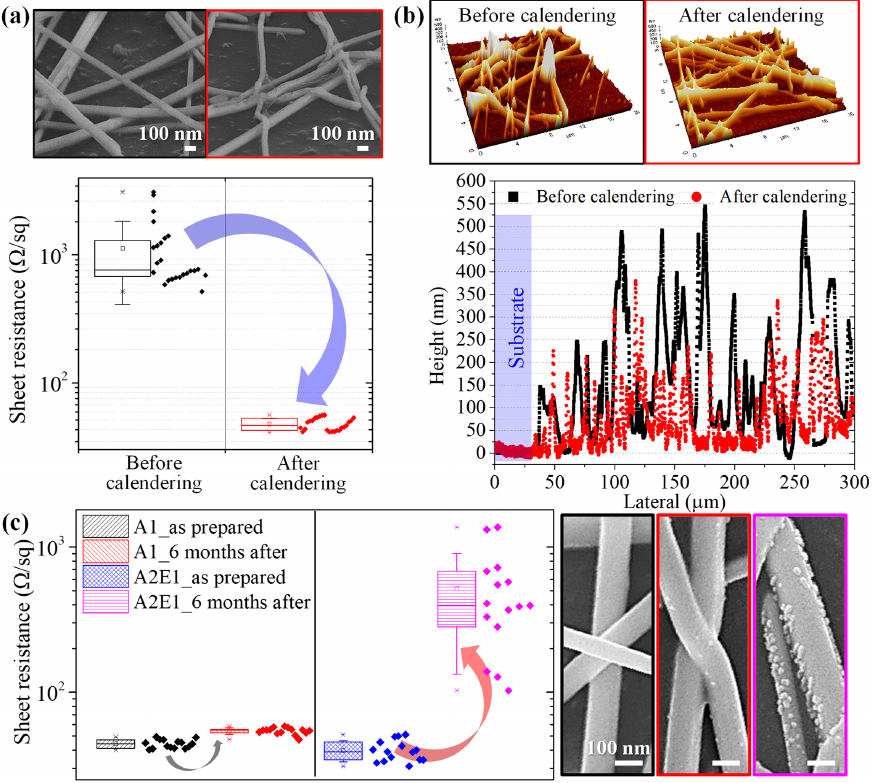
Figure 2. PVP-capped Ag NW TCFs calendered with flat roll: ( a ) FE-SEM images and sheet resistance change to demonstrate the effect of the calendering process, ( b ) AFM measurement of morphology. ( c ) FE-SEM images and sheet resistance change to show the effect of long-term oxidation when two different washing schemes (A1 and A2E1) were used.